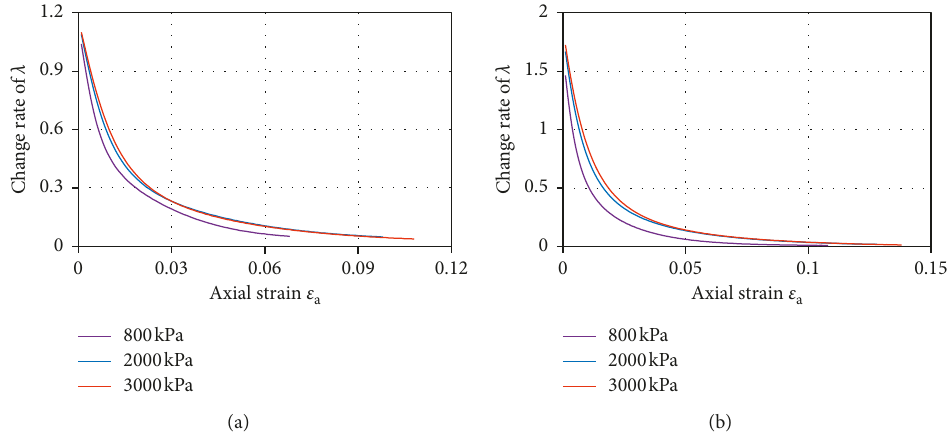
Figure 5: Variation rate of the compression index versus axial strain: (a) coarse granular soil I; (b) coarse granular soil II.